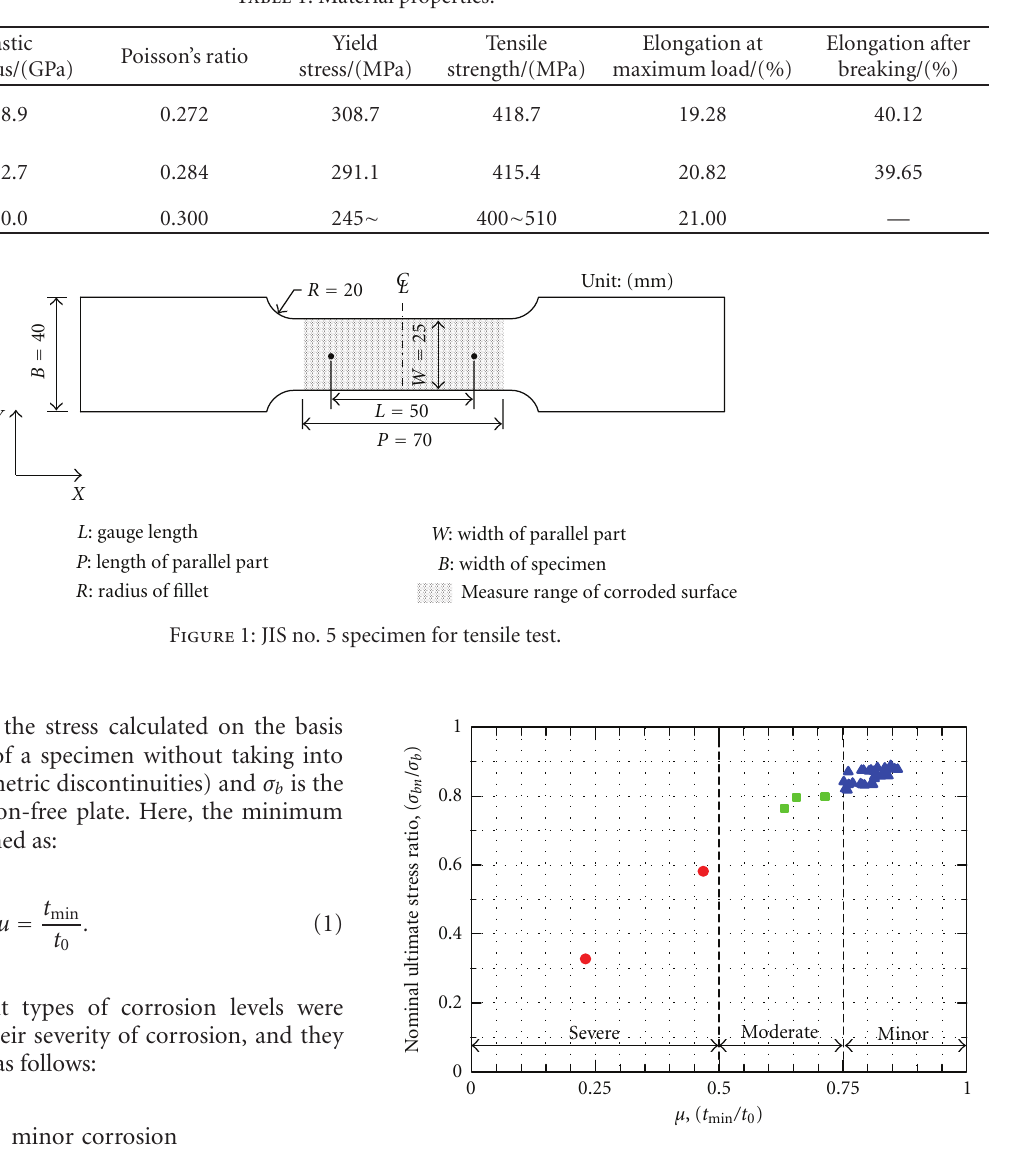
Table 1: Material properties.